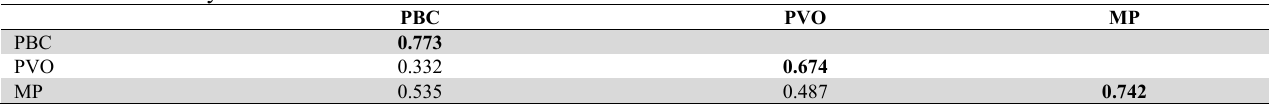
Discriminant Validity